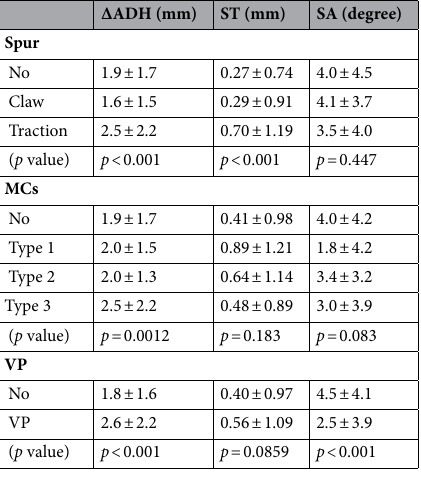
Table 3. Comparison between radiographic parameter and spur type, Modic changes, vacuum phenomenon. ADH, anterior disc height; ST, sagittal translation; SA, sagittal angulation; MCs, Modic changes; VP, vacuum phenomenon.